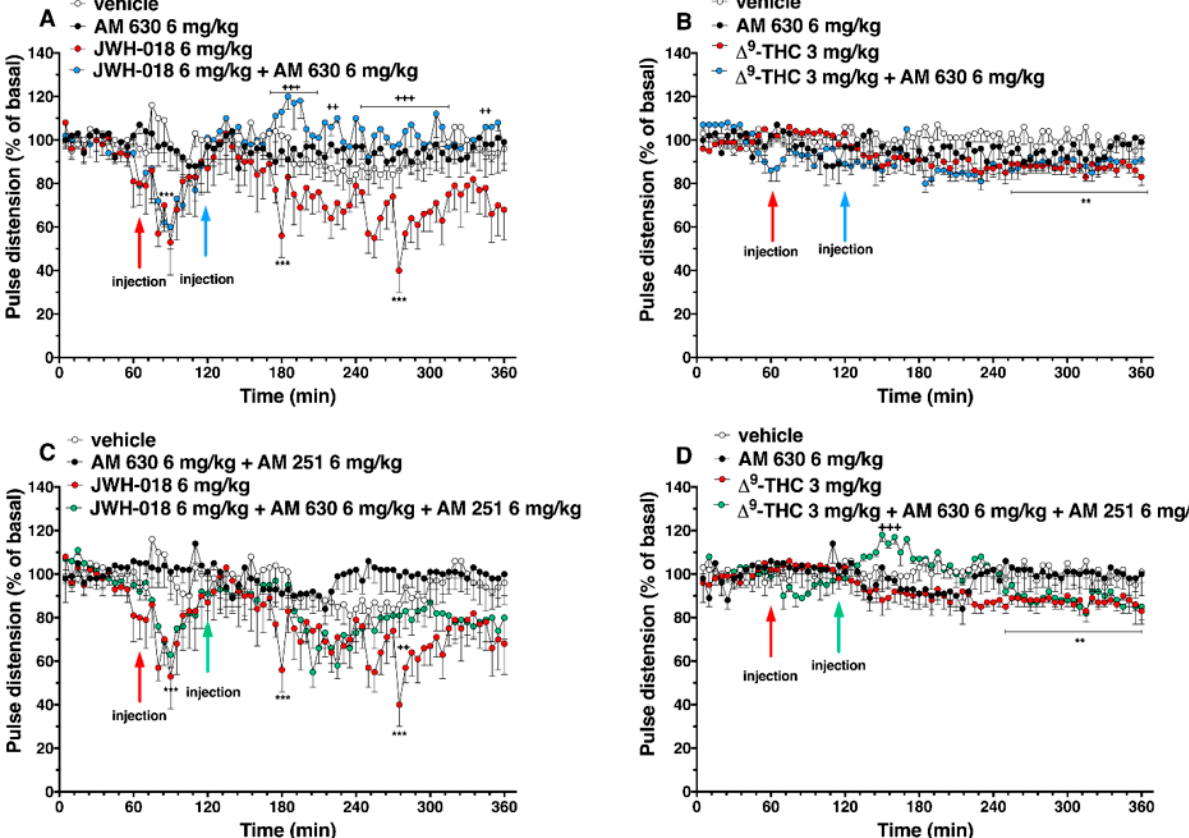
Figure 8. Interaction of JWH-018 (6 mg/kg i.p, panel ( A )) and ∆ 9 -THC (6 mg/kg i.p, panel ( B )) with the selective CB 2 receptor antagonist AM 630 (6 mg/kg, i.p.) on pulse distension. Interaction of JWH-018 (6 mg/kg i.p, panel ( C )) and ∆ 9 -THC (6 mg/kg i.p, panel ( D )) with the administration of the mixture of selective CB 1 (AM 251; 6 mg/kg, i.p.) and CB 2 (AM 630; 6 mg/kg, i.p.) receptor antagonists on pulse distension. Data are expressed as percentage of basal values in the form MEAN ± SEM of 8 different evaluations for each group. Statistical analysis was performed by two-way ANOVA, followed by Bonferroni’s test for multiple comparisons ** p < 0.01 *** p < 0.001 versus vehicle and ++ p < 0.01, +++ p < 0.001 versus AM 630 + agonists or AM 630 and AM 251 + agonists.